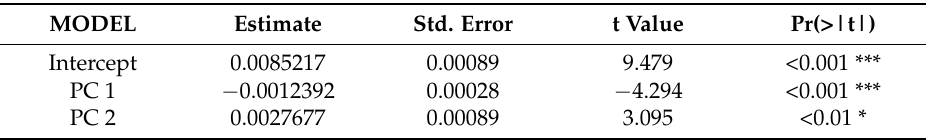
Table 5. Generalized linear models of total tree diversity (Shannon Index) with two principal components (PC1 and PC2), respectively.